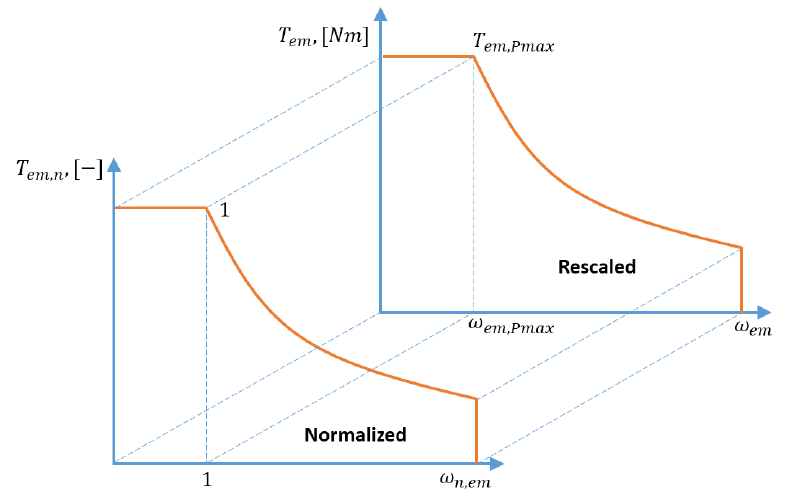
Figure 5. Graphical representation of the re-scaling procedure of the motor maximum torque charac-